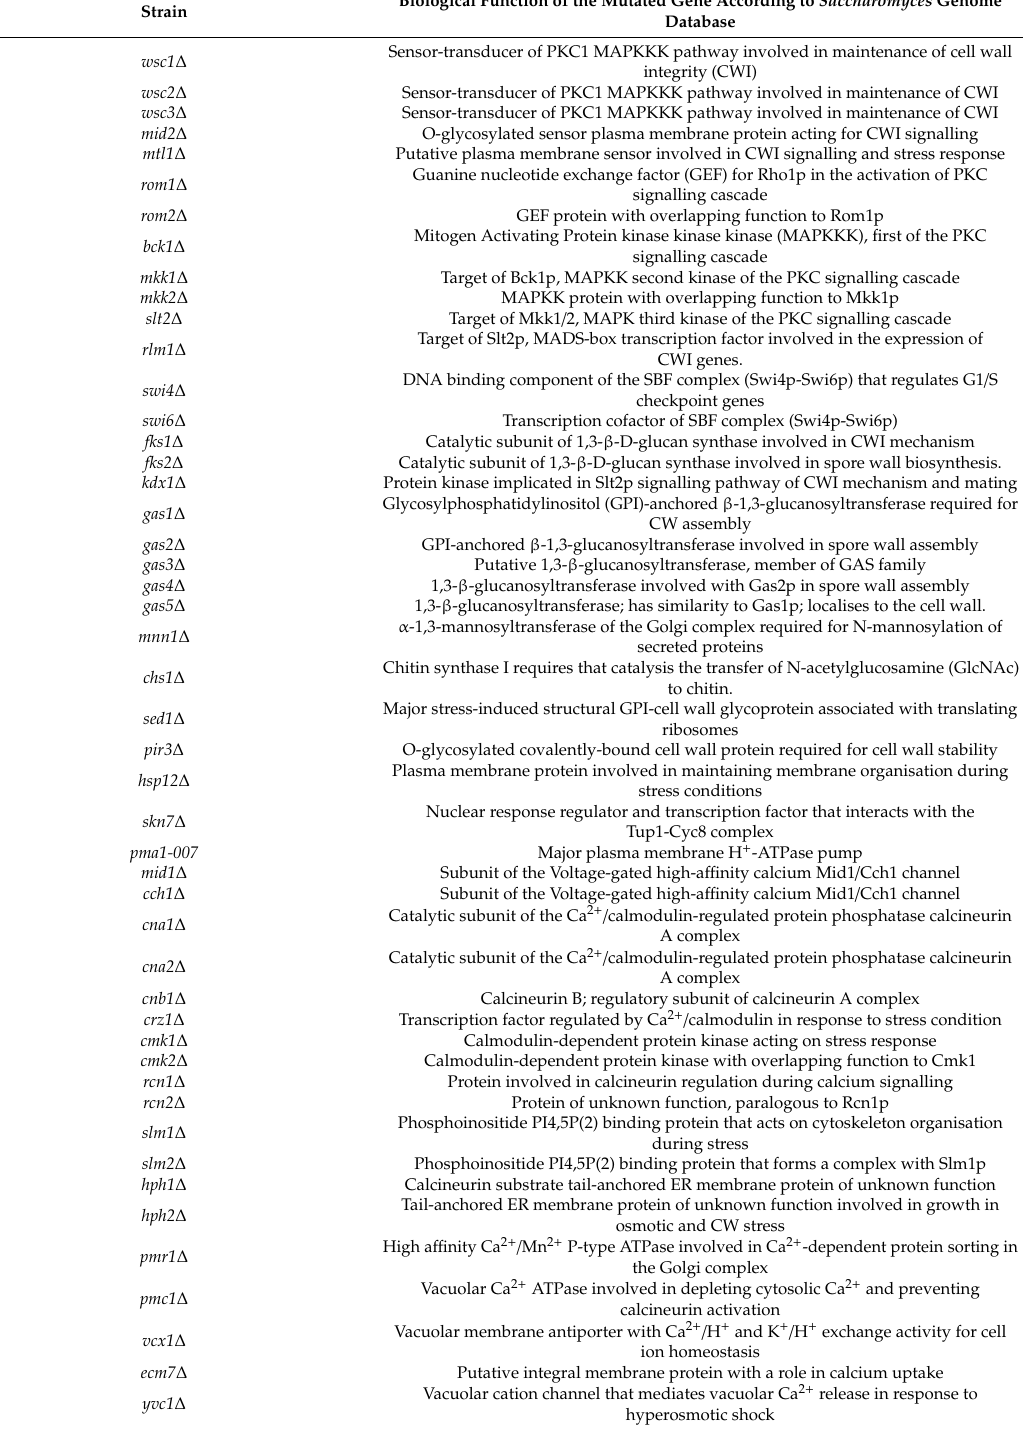
Table 1. List of S. cerevisiae isogenic mutant strains derived from BY4741 ( MAT α his3 ∆ 1 leu2 ∆ 0 met15 ∆ 0 ura3 ∆ 0 ) used in the present